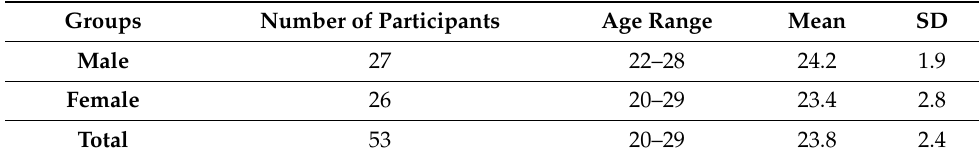
Table 2. The numbers of participants in gender groups.